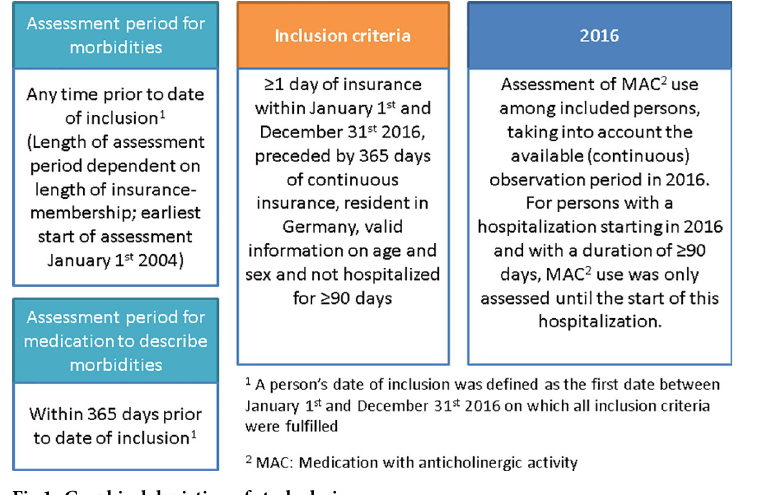
Fig 1. Graphical depiction of study